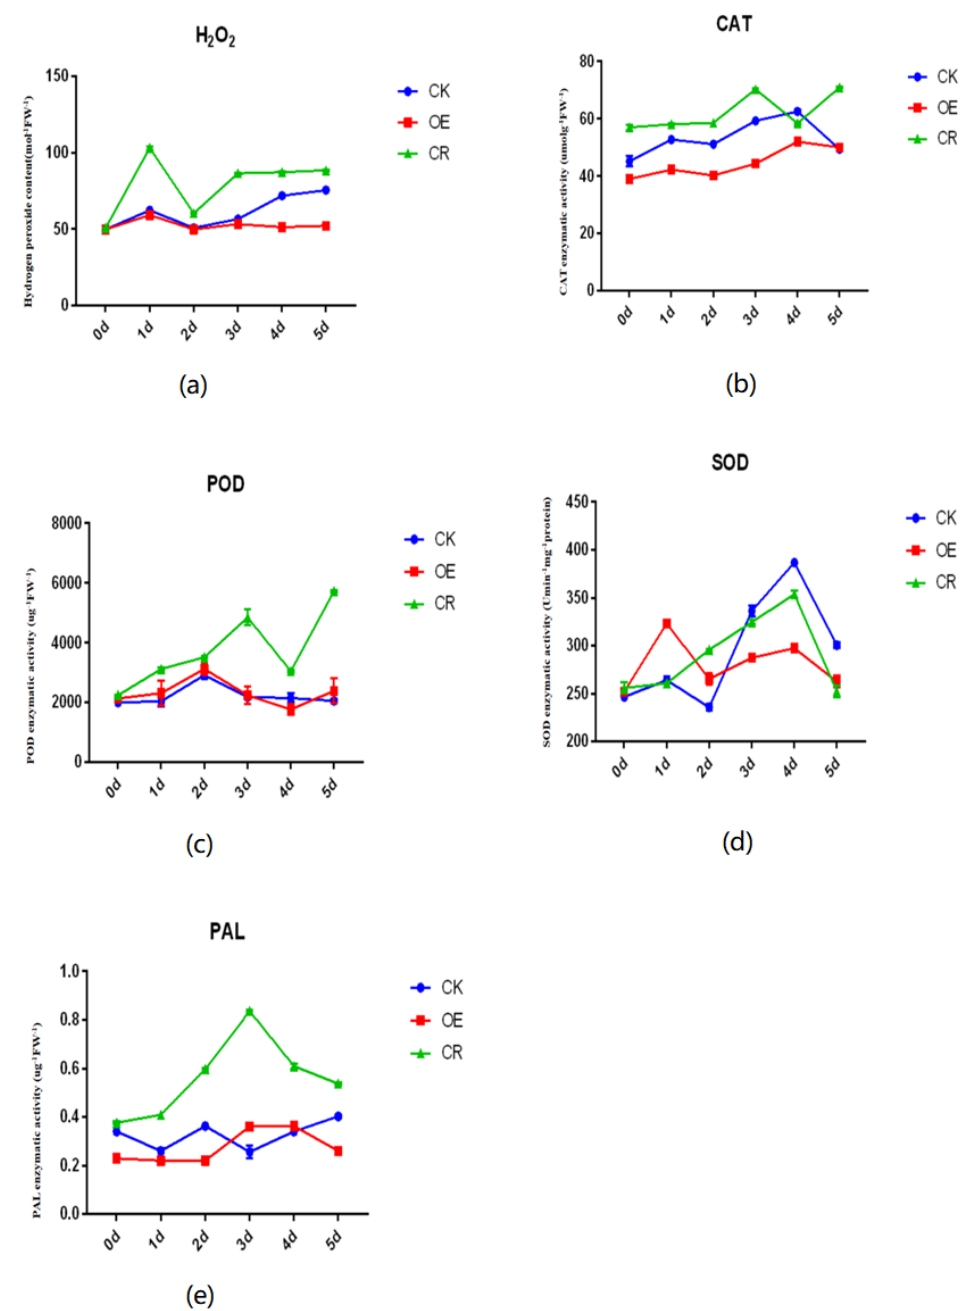
Figure 3. ( a ) Change in H 2 O 2 content in transgenic plants; ( b ) changes in CAT enzyme activity in transgenic plants; ( c ) changes in POD enzyme activity in transgenic plants; ( d ) changes in SOD activity in transgenic plants; ( e ) changes in PAL enzyme activity in transgenic plants. CK: control plants; OE: transgenic plants overexpressing the ZmBON3 gene; CR: ZmBON3 -gene-edited plants. All of the materials were taken from trileaf-stage plants. Each set of data showed an average of the relative expression levels, and similar results were obtained in three separate experiments.